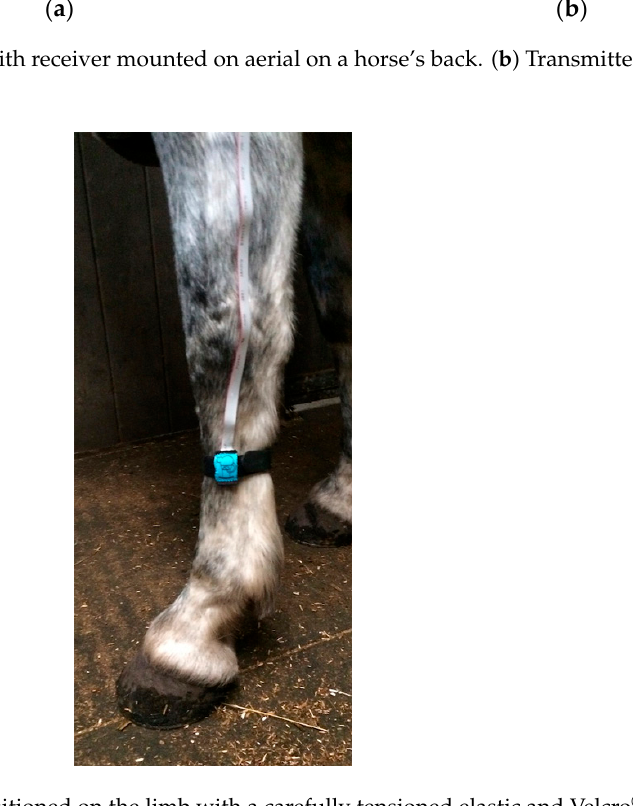
Table 1. Skin temperature (°C) (range) and thermal nociceptive threshold (°C) (TT) (mean ± SD (range)) recorded with a remote controlled system during training in cats, dogs, sheep, horses and camels.